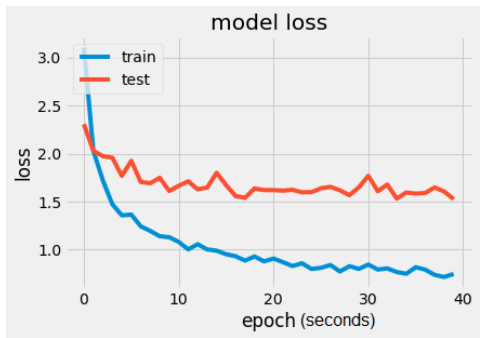
Figure 9. MobileNet model loss.